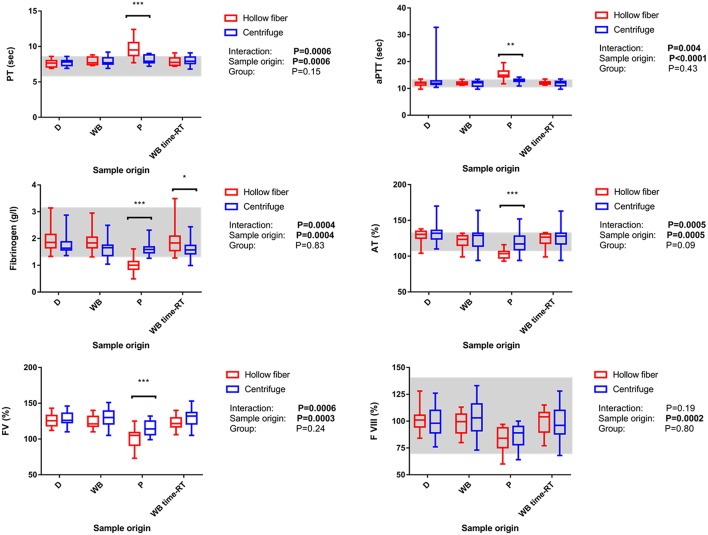
Impact of origin of sample reflecting the different steps of the blood separation process and the system used for blood separation (i.e., centrifuge or the hollow-fiber system) on coagulation parameters as well as interaction between the factors “origin of sample” and “system” Data is shown as box-and-whisker diagrams. The central line represents the median, the box the 25 and 75% percentile, and the whiskers are consistent with the range. The reference interval is indicated as gray area. Significant pairwise comparisons were marked with *-***; whereby *P < 0.05; **P < 0.01, and ***P < 0.001, respectively. D, blood samples from blood donor prior donation; WB, blood samples from Whole blood bags after donation; P, plasma samples from plasma bag after separation process; WB time-RT, sample taken from the whole blood bag prior to the blood separation process to assess the sole impact of time at room temperature; PT, prothrombin time, aPTT, activated partial thromboplastin time; AT, antithrombin activity; FV, factor V activity; FVIII, factor VIII activity.